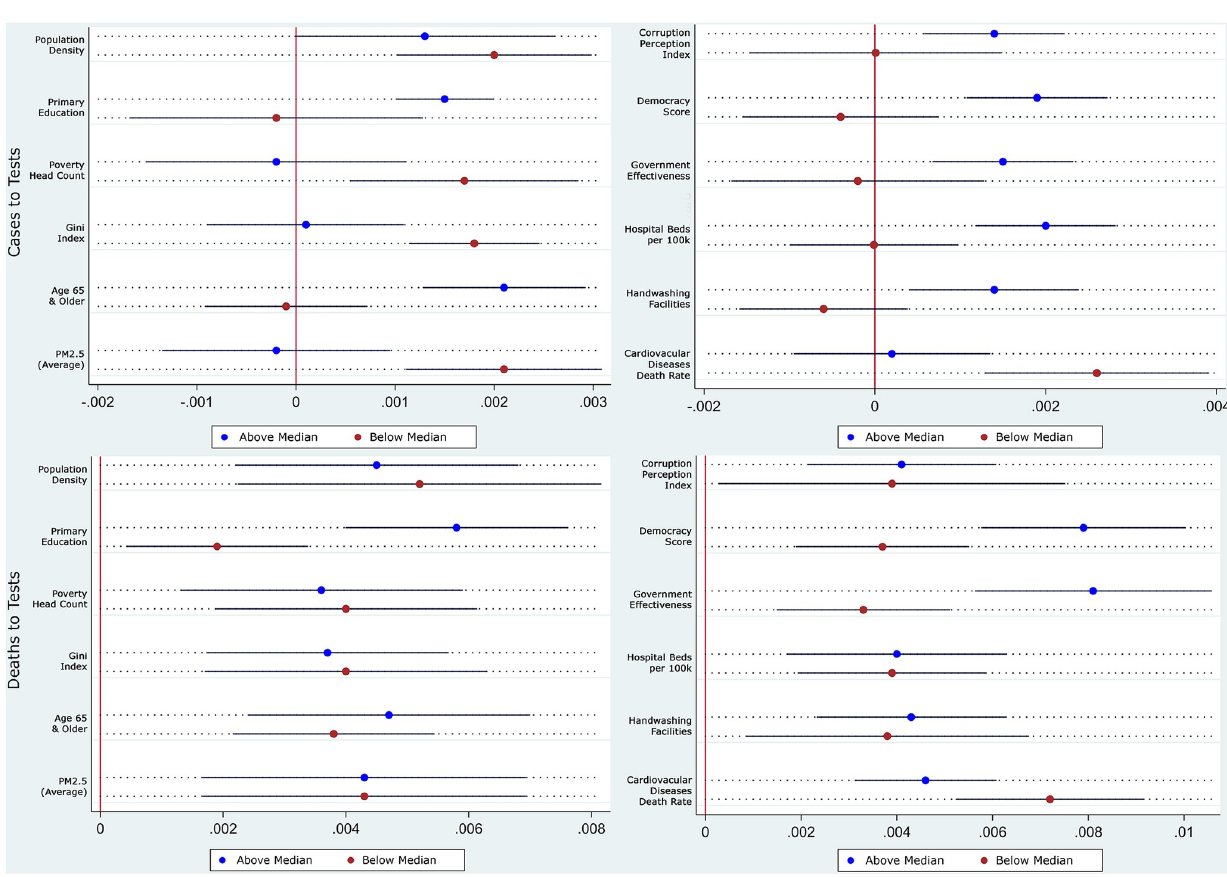
Fig 4. Coefficient plots of hetegeneous impact of transit station mobility on growth rates: Recursive mixed-process model. Coefficient plots are constructed using results from Table 8 with 90% confidence intervals.